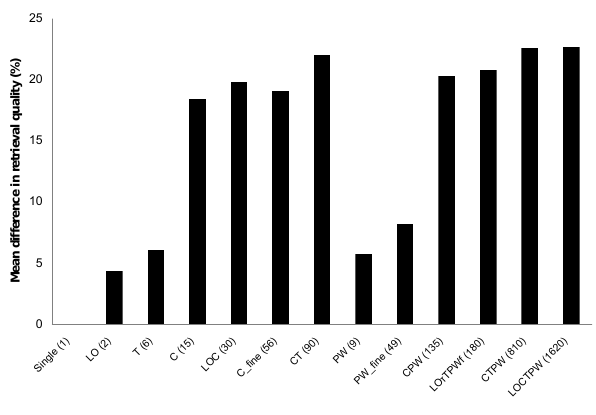
Fig. 8. Mean difference between HDO retrieval quality within each category and the overall quality for the Single categorization (68%), for twelve different categorizations. Differences are weighted by frequency of occurrence within each category. Numbers in paren- theses indicate the total number of categories in each categorization.